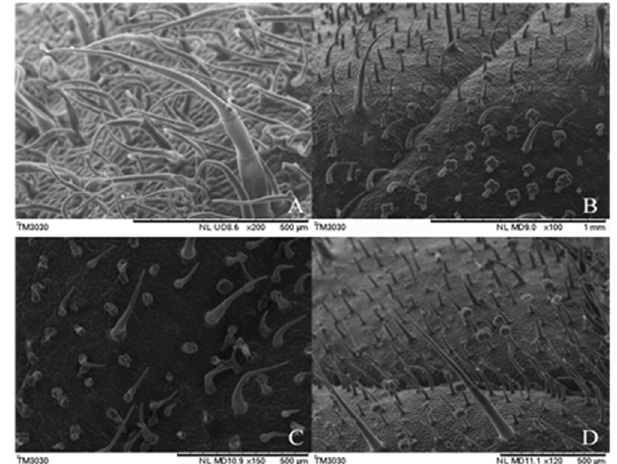
Figure 5. Scanning electron microscopy images of trichome density (per unit area) in 3186M, 3186L, 3-071, JR. 3186M (tomato wo mutant, hairy), 3186L (tomato wo mutant, hairless), 3-071 (tomato ln mutant, hairless), and JR (tomato cultivar Jia Ren). A scanning electron microscope observation of the state of trichome of each tomato accession per unit area. ( A ) The 3186M trichome numbers of the per unit area at 100x magnification. Bar = 500 µ m. ( B ) The 3186L trichome numbers of the per unit area at 100x magnification. Bar = 1 mm. ( C ) The 3-071 trichome numbers of the per unit area at 100x magnification. Bar = 500 µ m. ( D ) The JR trichome numbers of the per unit area at 100x magnification. Bar = 500 μ m.